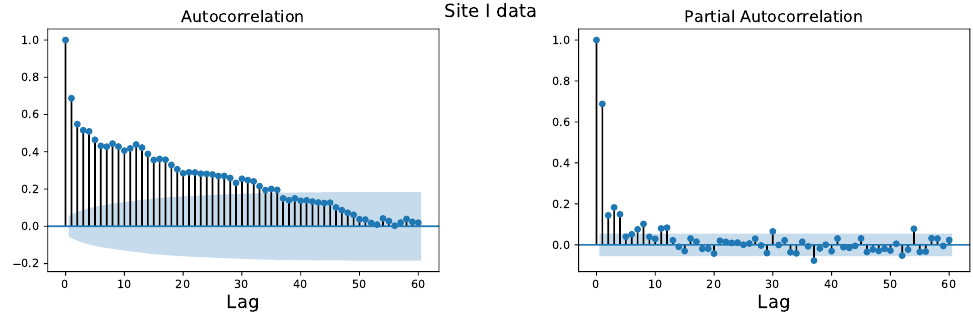
Figure 5. Autocorrelation ( left ) and Partial Autocorrelation ( right ) for Site I. The autocorrelation plot for daily wind power production shown in Figure 6 reveals that most of the spikes are statistically significant, except for lag 29. This confirms that the time series data of wind power production are strongly correlated with its lag values, as depicted in Figure